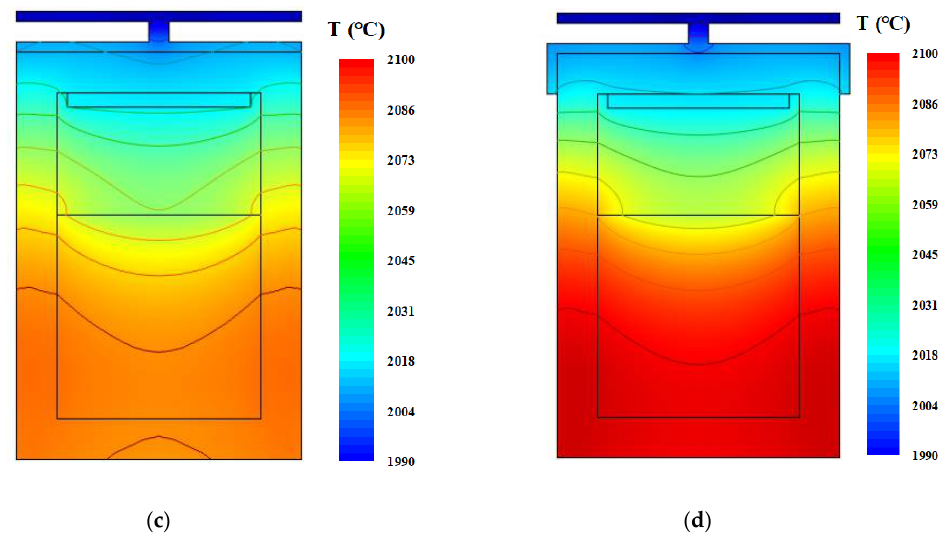
Figure 2. Temperature distributions for ( a ) the original design, ( b ) A design, ( c ) B design and ( d ) C design.